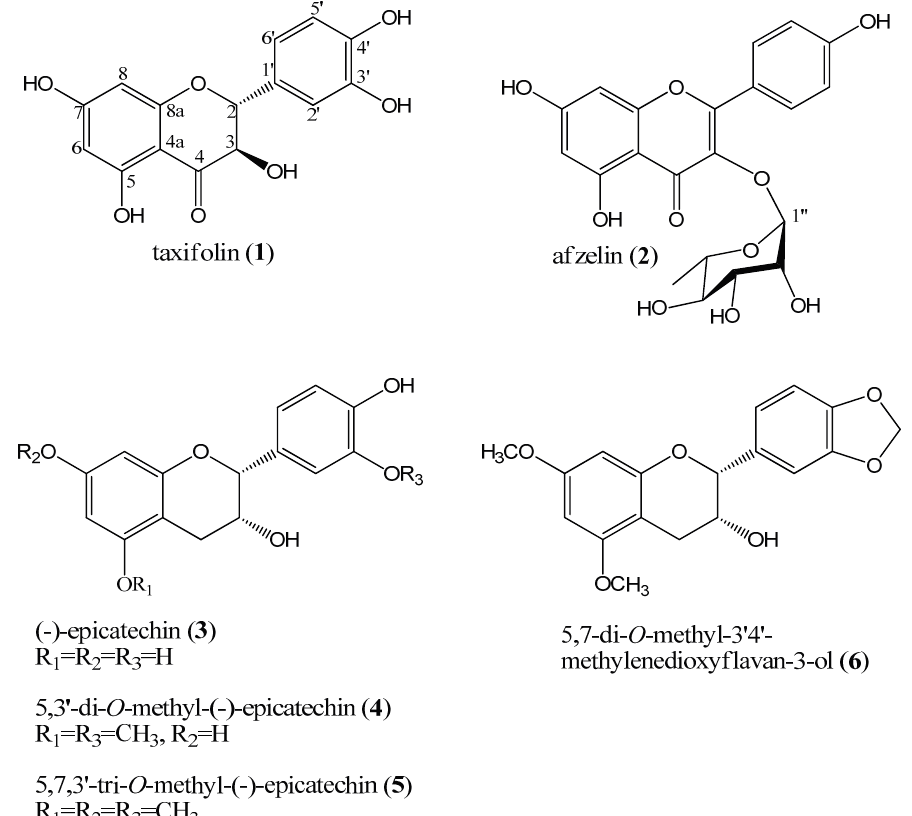
Figure 1. Chemical structures of the six flavonoids isolated from the stem of M. japonica